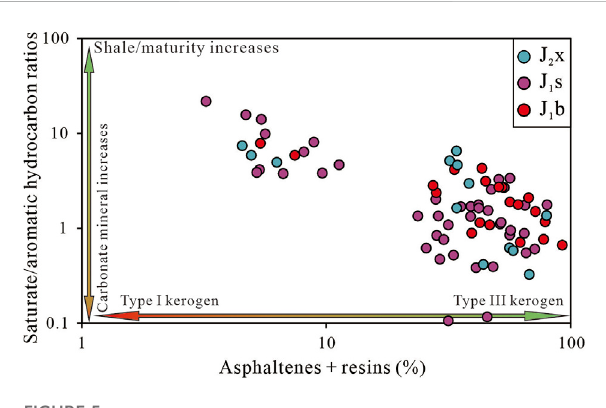
FIGURE 4 δ 13 C δ 13 C Saturate vs Aromatic for the extractable organic matter from the Jurassic organic-rich shale in the East Fukang Sag, Junggar Basin, China. The green line is the best fi t separation for waxy and non-waxy hydrocarbons (Sofer, 1984).